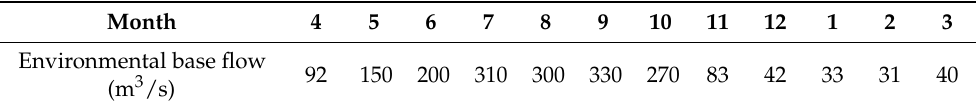
Figure 5. The downstream of the Liujiaxia Reservoir water supply for domestic, industry, and agricultural use in a wet year, normal year, and dry year.